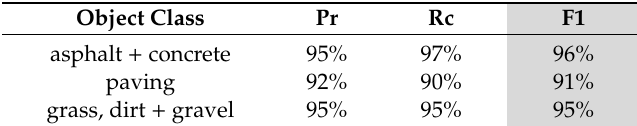
Table 4. Combined evaluation of related surface classes (mean over all data sets).